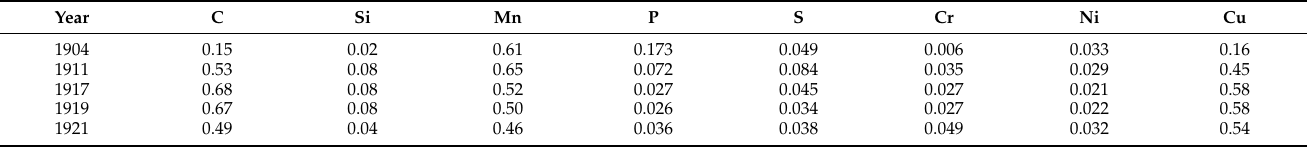
Table 1. Chemical composition of the rail steels manufactured by Hanyang Iron Works (mass